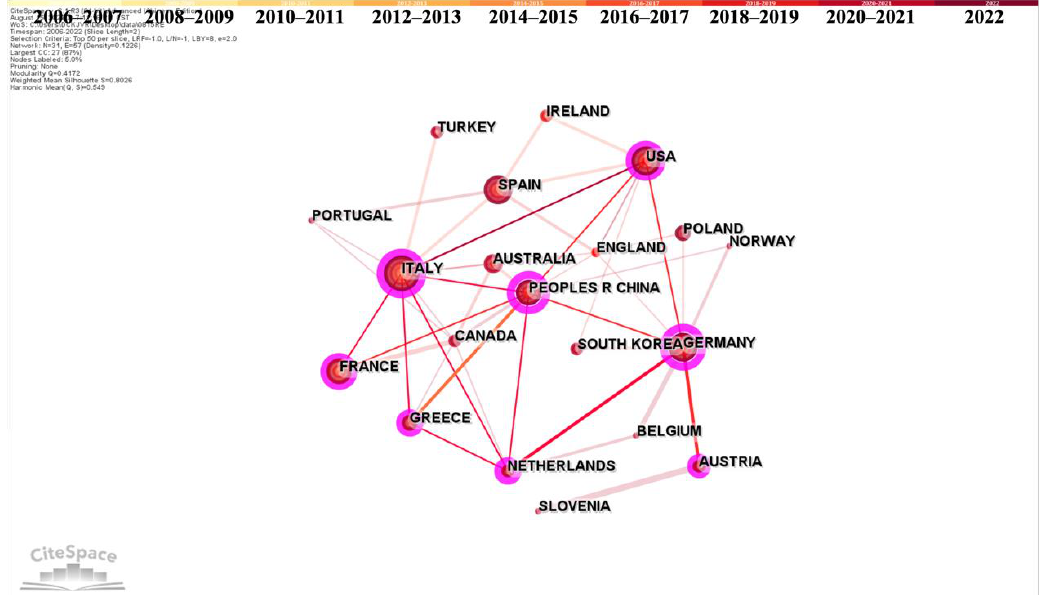
Figure 7. The visualization of the collaborative country network.